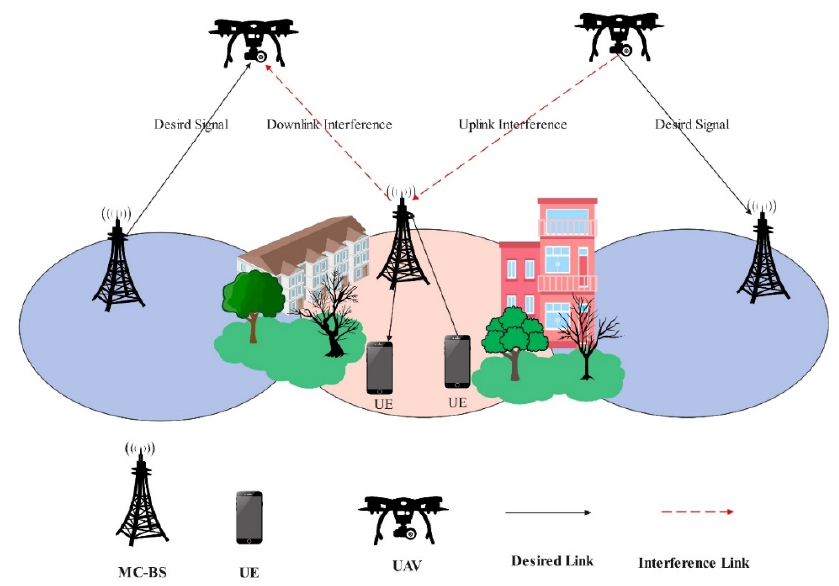
Figure 15. Interference in a UAV